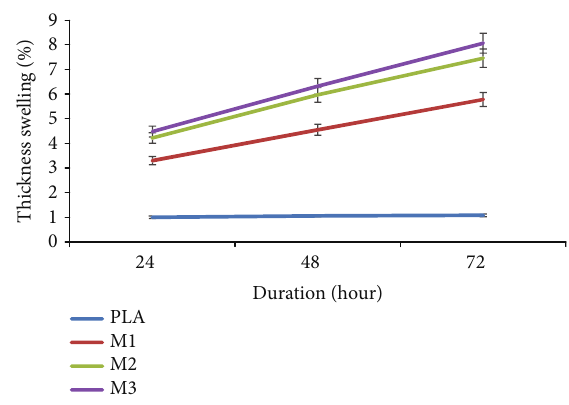
Figure 6: Thickness swelling level of PLA/MF